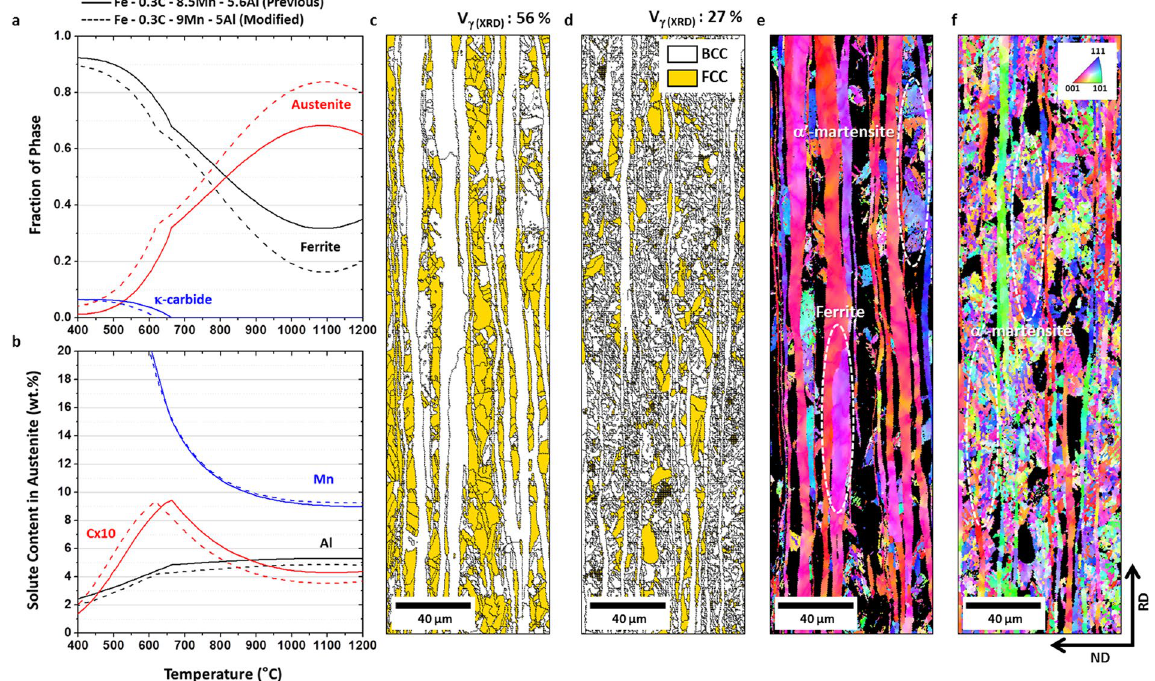
Figure 1. Phase calculations and actual hot-rolled microstructures of previous and modified steels. ( a ) High- temperature equilibrium phase distribution. ( b ) Solute contents in the austenite phase calculated by using ThermoCalc 28–30 . ( c–f ) EBSD phase and inverse pole figure (IPF) maps. All the EBSD maps are obtained from hot-rolled plates. Both steels have (ferrite + austenite) duplex microstructures in a banded shape elongated along the rolling